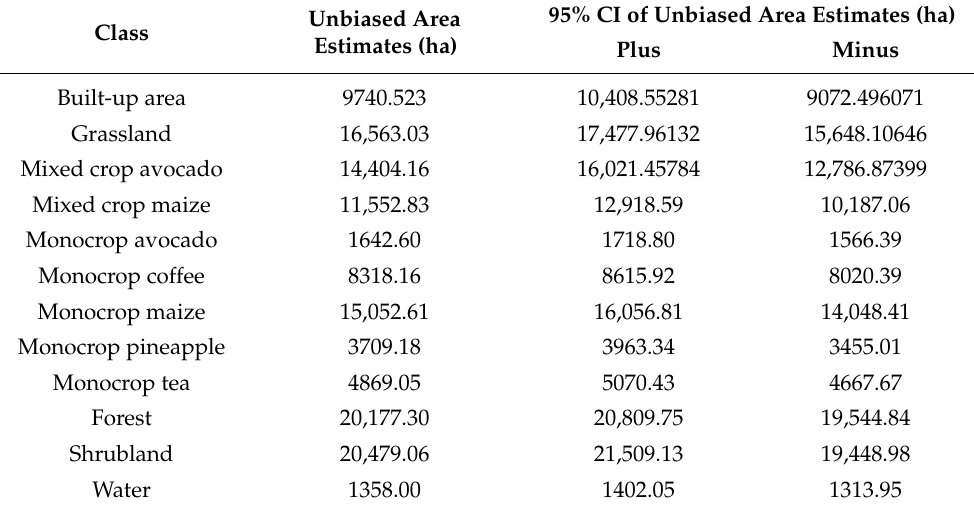
Table 9. The unbiased area estimates and approximate 95% confidence intervals (CIs) of the crop- ping patterns and non-croplands obtained using the area under class method of the most accurate variables combination result from the guided regularized random forest-selected variables of sce- nario C5. C5 = Sentinel-2 reflectance bands (S2 bands), vegetation indices (VIs), and Sentinel-1 (S1) backscatter